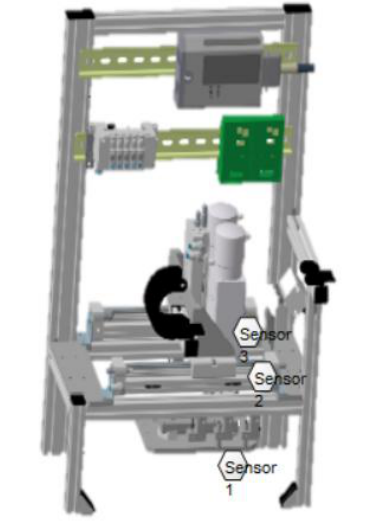
Figure 12. Asset layer, equipment